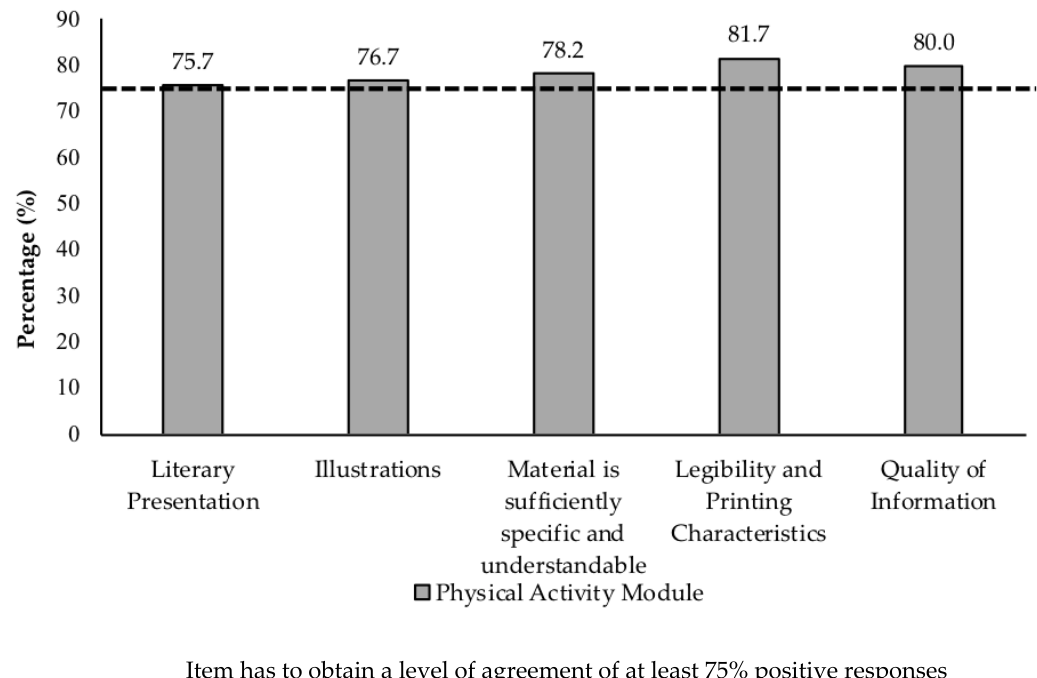
Figure 2. Level of agreement among adolescent target audience for evaluative aspects of face validity.